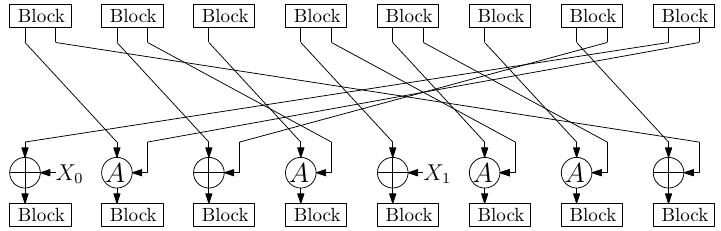
Figure 6: The round function whose # of blocks is 8.